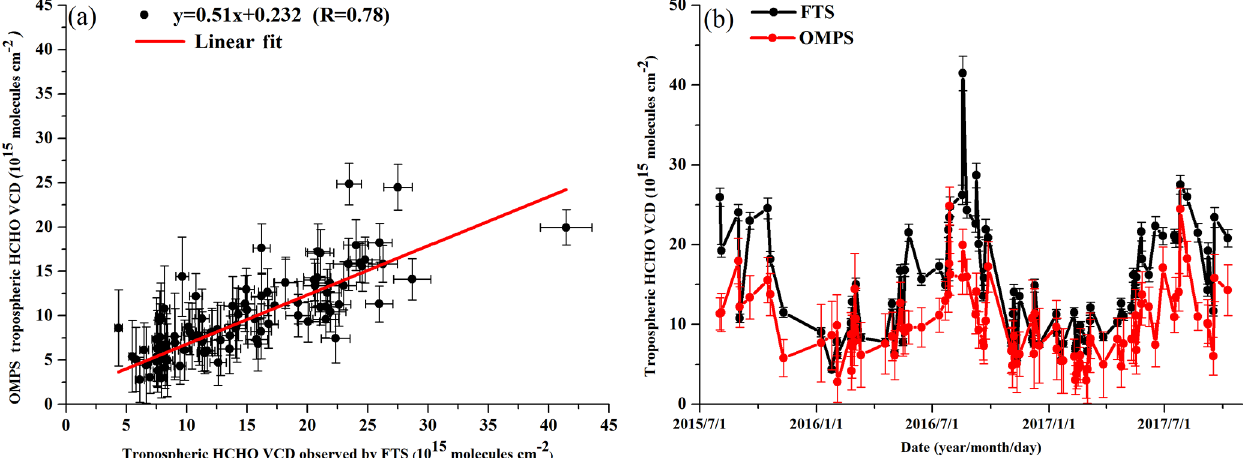
Figure 1. Correlation analysis (a) and time series (b) of tropospheric HCHO VCDs measured by OMPS and FTS from 1 July 2015 to 20 November 2017.